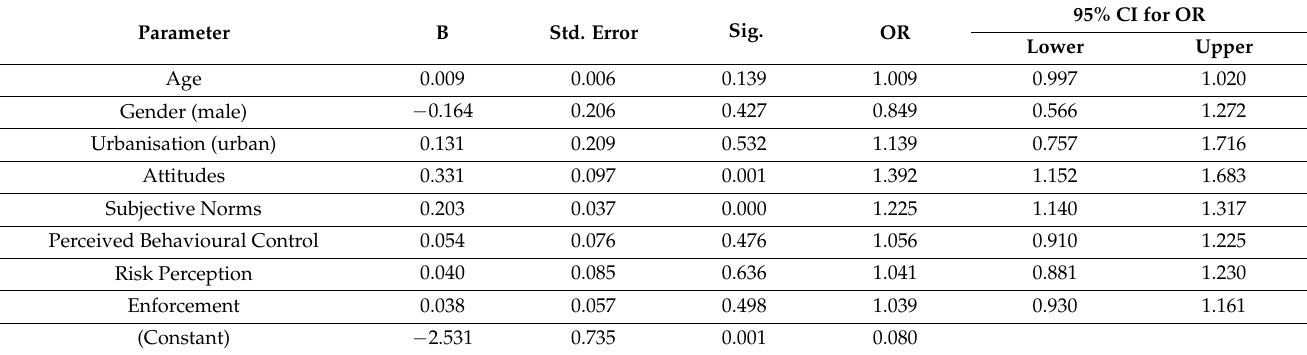
Table 6. Factors influencing speeding on freeways and